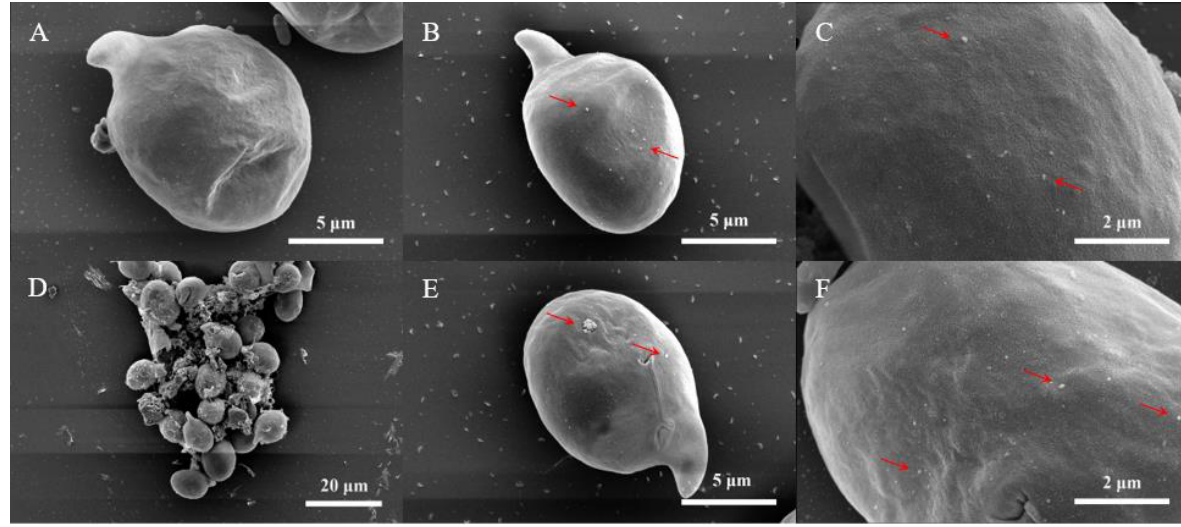
Figure 4. SEM images of A. carterae in the control ( A ), 100 mg/L of nano-PS ( B – D ) on day 2, and 100 mg/L of nano-PS ( E , F ) on day 8. The arrows point to the nano-PS adhered to the algae cell.